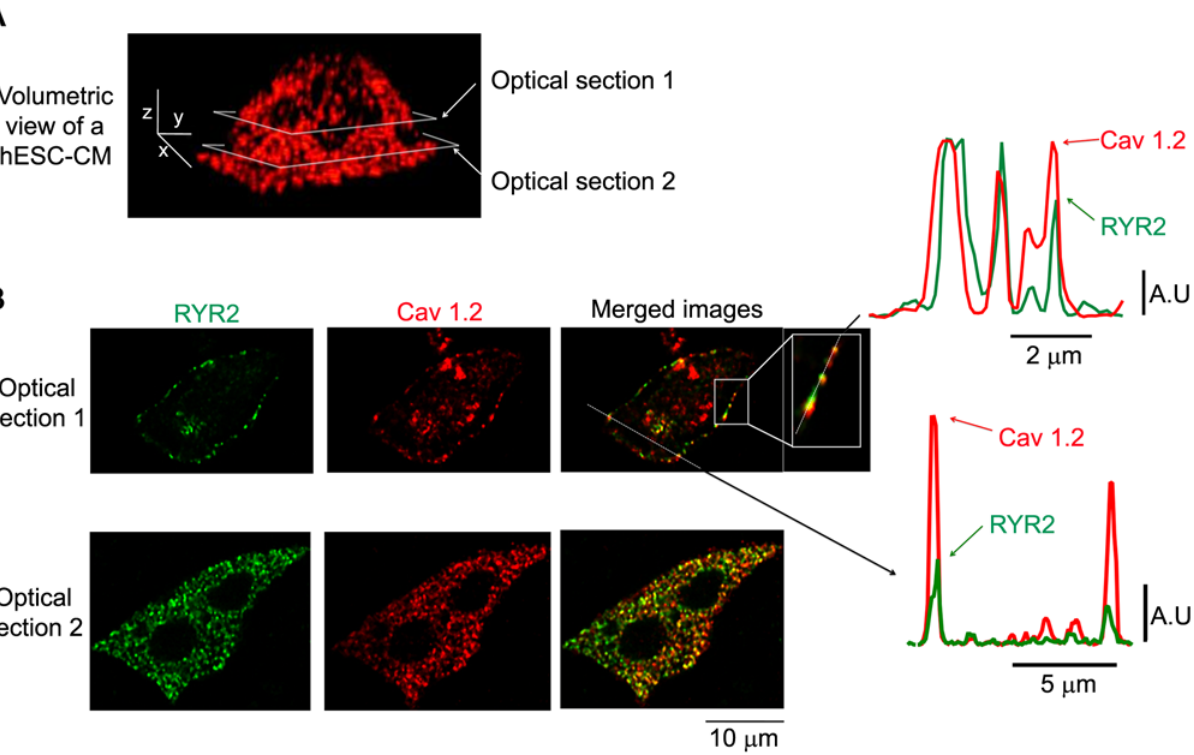
Figure 5. Immunofluorescent co-localization of RyR2 and L-type Ca 2 + channels in hESC-CMs. A. Volumetric view of a stack of confocal anti-Cav1.2 images from a representative hESC-CM. Images were collected every 0.25 m m in the z-axis. The scale bars in the image indicate 5, 2, and 5 m m along the x, y, and z-axes, respectively. The horizontal grey boxes show the location of the two optical sections depicted in panel B. B. Two- dimensional anti-RyR2 (green, left), anti-L-type Ca 2 + channels (anti-Cav1.2, red, center), and merged images, corresponding to optical sections 1 and 2 from panel A. Note that the merged image from optical section 1 includes two dotted lines, one that runs along the cell membrane (magnified in the inset) and one that traverses the cell. The corresponding plots to the right indicate the two-channel fluorescent intensity along each of the aforementioned lines.